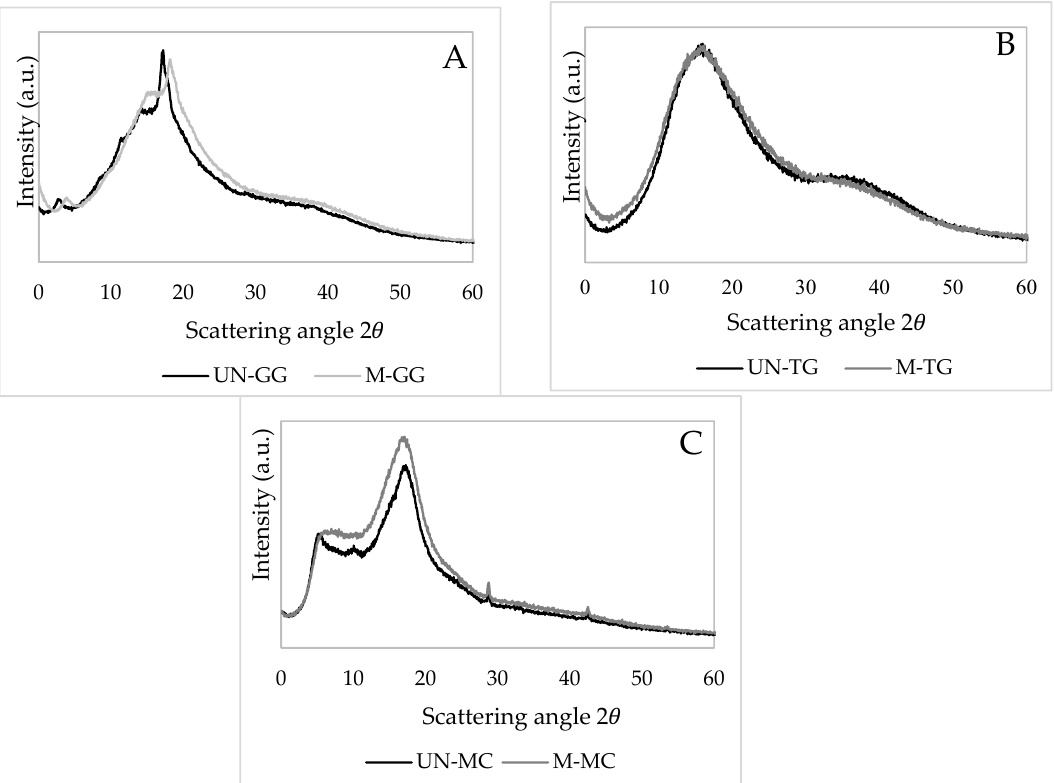
Figure 1. X-ray diffraction patterns of un-milled (continuous dark line) and milled (continuous grey line) hydrocolloids: guar gum ( A ), tara gum ( B ), and methylcellulose ( C ). UN: un-milled; M: milled; GG: guar gum; TG: tara gum; MC: methylcellulose.